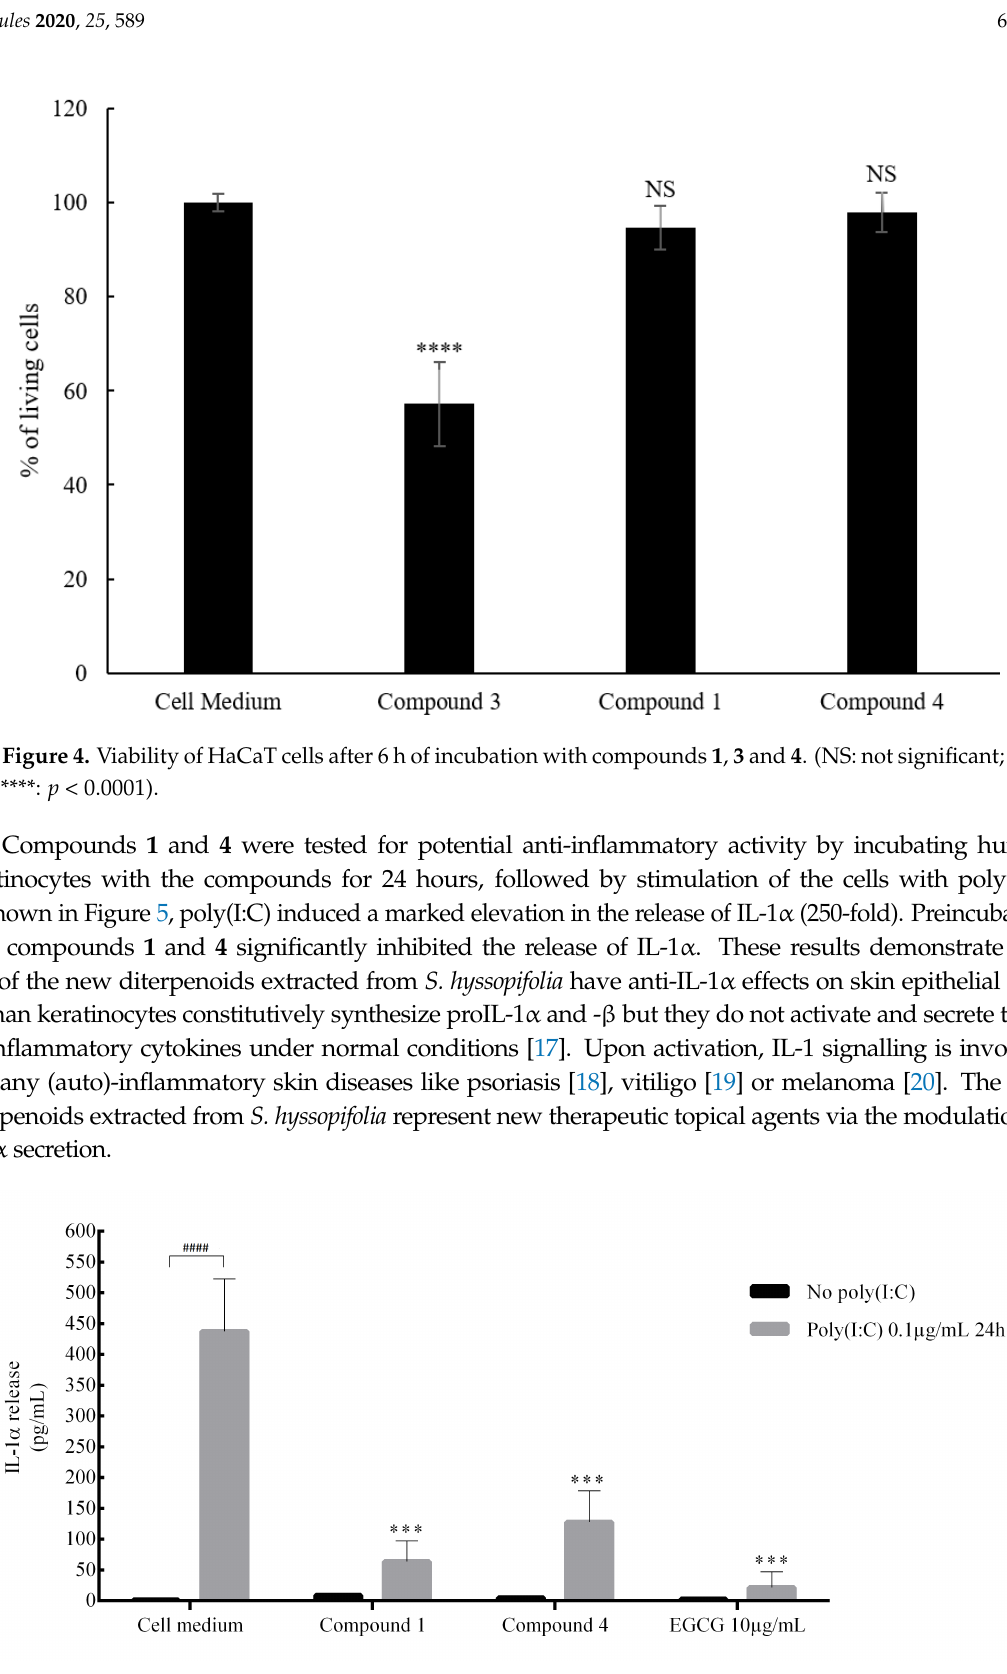
Figure 5. Anti-inflammatory activity of compounds 1 and 4 in HaCaT cells stimulated by poly(I:C). Compounds in ethanol were prepared at 1:100 dilution in cell medium to obtain a concentration of 10 µ g/mL (***: p < 0.001 compared to cell medium with poly(I:C); ####: p <